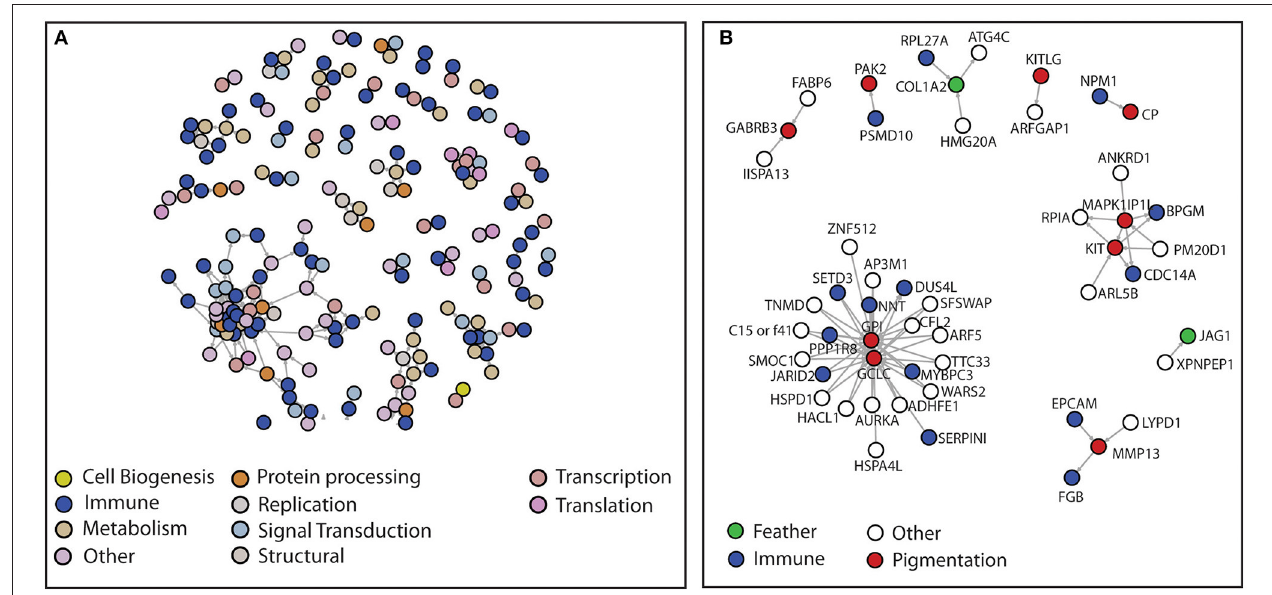
FIGURE 4 | Evaluation of the Hamilton-Zuk hypothesis. (A) Network diagram of known functions and unambiguously annotated genes which passed the heterogeneity and quality test for ω . The nodes represent the genes and edges represent the phylogenetically corrected correlation ( r -squared value > 0.9 at FDR q -value < 0.01) between the ω values of the two genes (nodes) across all the species. The color coding was done to highlight specific cellular functions ( Supplementary Tables 5 – 7 ). (B) A sub-network from panel-A where only the immune-related, feather-related, and pigmentation-related nodes (genes) are